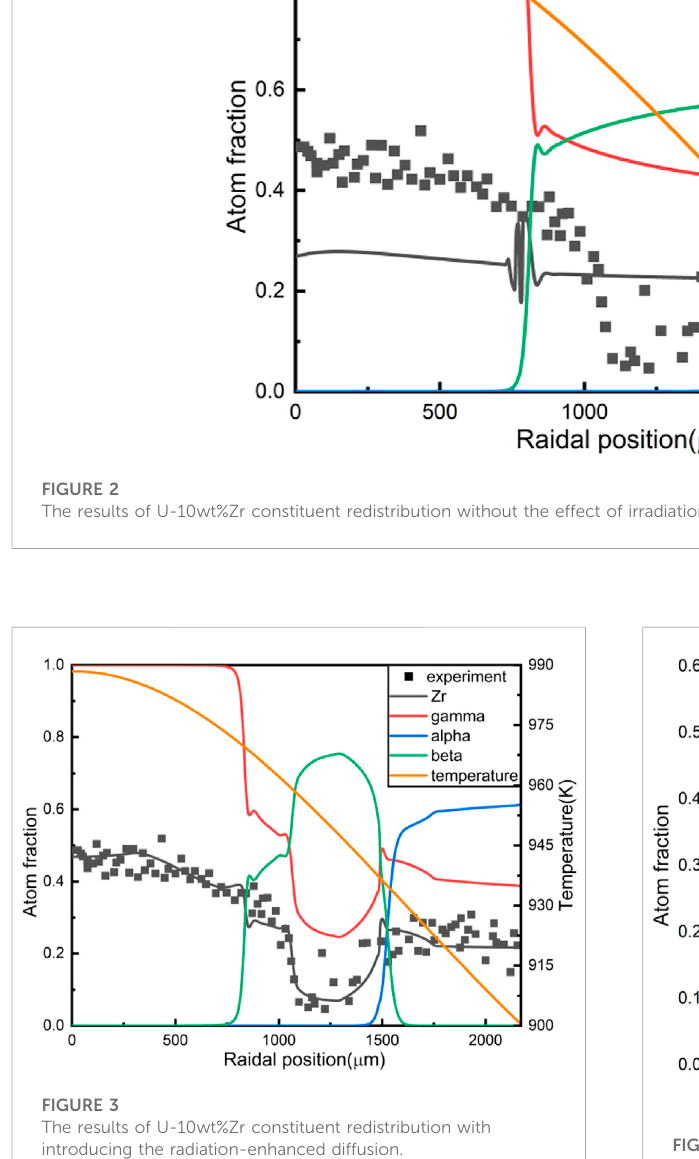
The U-10%Zr constituent redistribution obtained by different